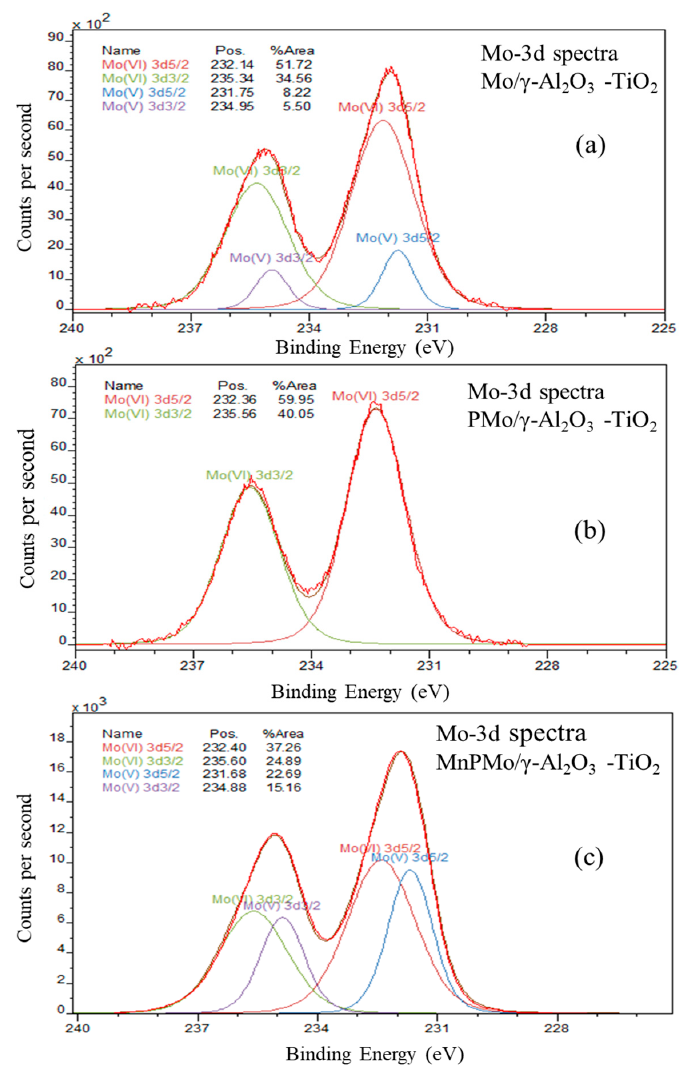
Figure 6. Mo 3d XPS spectra for ( a ) Mo/ γ -Al 2 O 3 -TiO 2 , ( b ) PMo/ γ -Al 2 O 3 -TiO 2 and ( c ) MnPMo/ γ -Al 2 O 3 -TiO 2 .